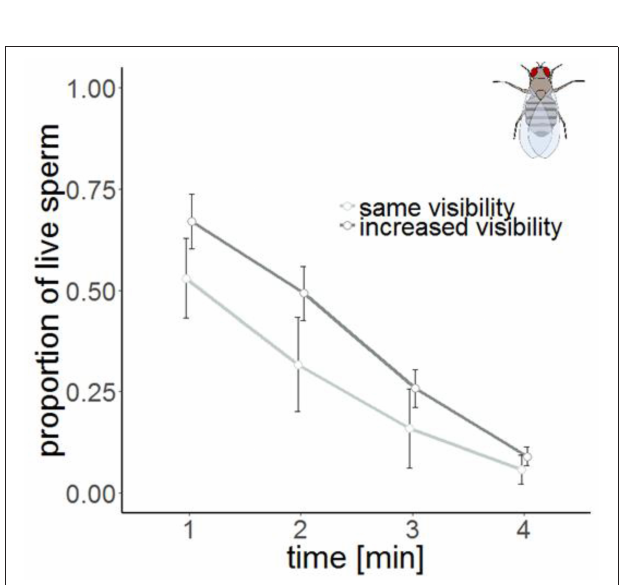
FIGURE 5 | Sperm viability in samples with the same visibility ( n = 4, light gray) and increased visibility ( n = 6, dark gray) in Drosophila melanogaster at four different points in time. Bars show mean ± s.e.